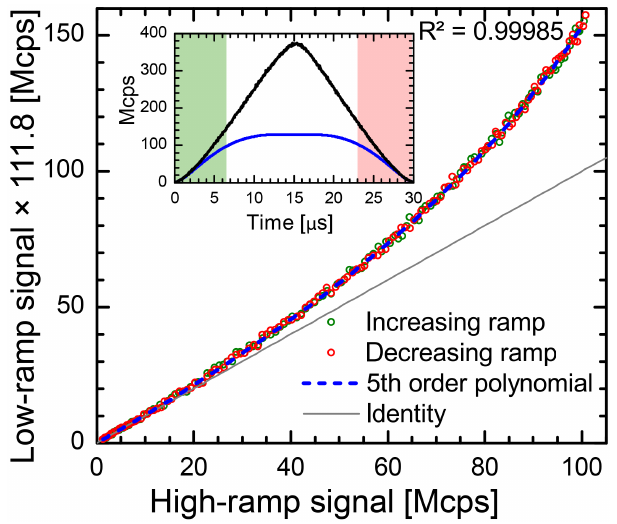
Figure 6. Measurement of dead-time effect of the 355nm PMT of Polly XT _TROPOS: a light ramp was detected with high and low (by use of an attenuator) count rates, respectively. The inset shows the light ramps with high count rates (blue) and with low count rates (black) but scaled (by a factor of 111.8) so that both curves match the identity line at count rates < 10Mcps. The main graph shows the dead-time correction function which results from plotting the true count rate (black line from the inset) over the measured count rate (blue line). In addition, a 5th-order polynomial fit which can be applied for dead-time correction is